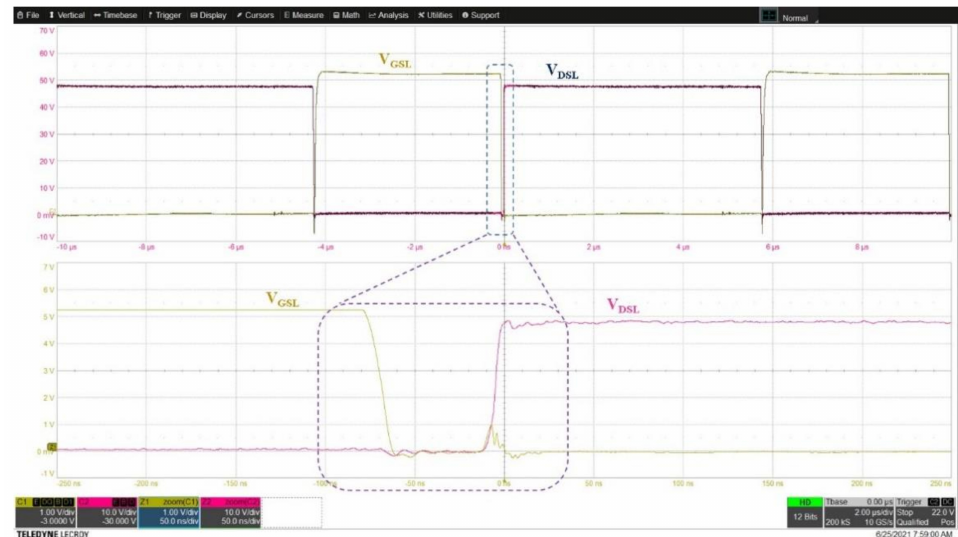
Figure 25. Experimental waveforms of the gate-source voltage of the lower device of inverter leg (phase a) under the rise of the inverter leg node voltage (lower device-drain-source voltage). The dv/dt effect acts a gate voltage spike under the GaN threshold voltage (V GSTH ) V DSL =10 V/div, V GSL =1 V/div, t main =2 µ s, t zoom = 50 ns/div.